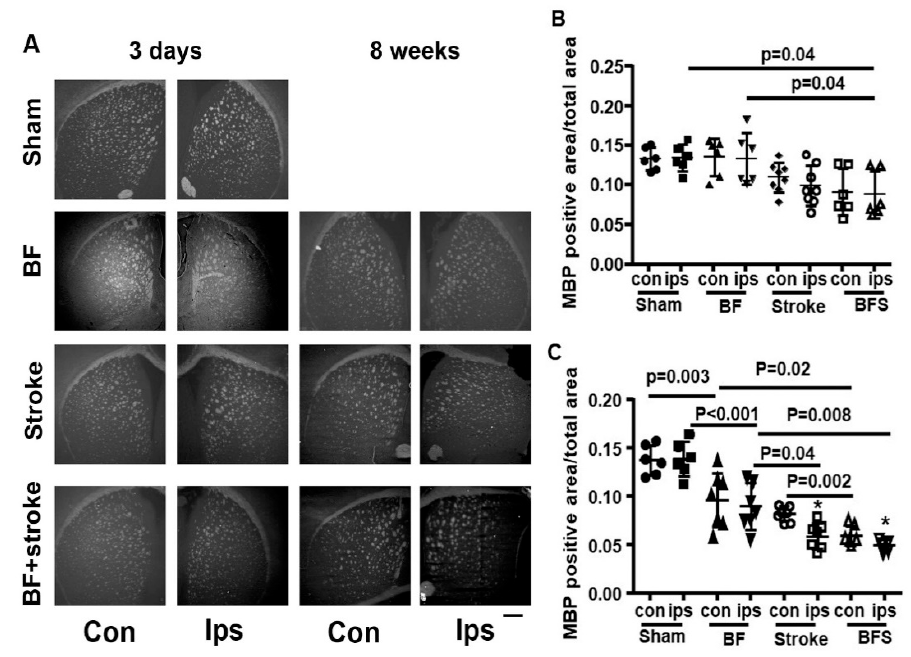
Figure 5. BF exacerbated WM damage in the basal ganglia of the stroke brain. ( A ). Representative images of MBP antibody stained (white) sections. 3 days: 3 days after injuries. 8 weeks: 8 weeks after the injuries. Scale bar: 500 µm. ( B , C ). Quantification for MBP positive area in basal ganglia at 3 days ( B ) and 8 weeks ( C ) after the injuries. *: p < 0.001 vs sham ipsilateral side of stroke. N = 5–8. con: contralateral to stroke injury. ips: ipsilateral to stroke injury. BFS: BF 6 h before stroke.